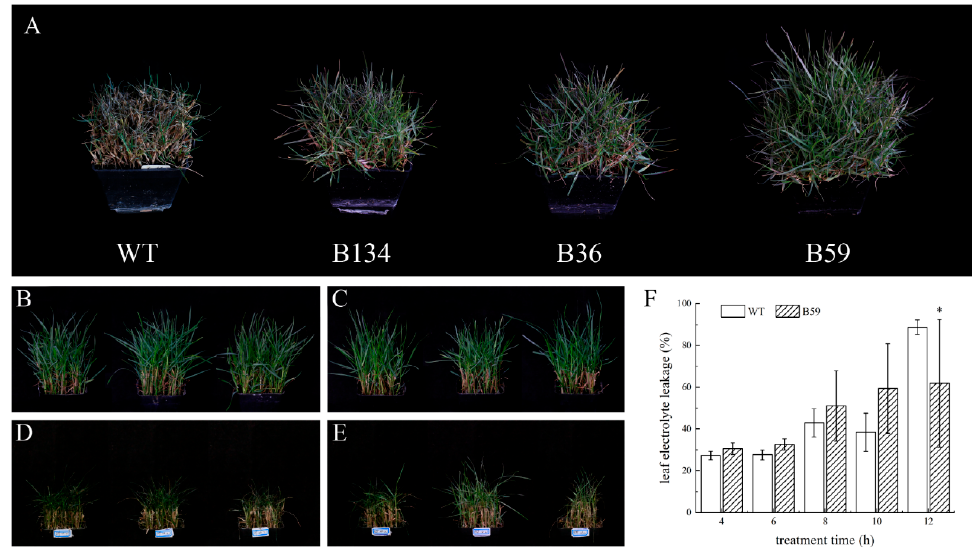
Figure 7. The performance of WT and B59 after freezing treatment. ( A ) Materials that perform well after the cold wave; ( B ) WT at 28 °C before freezing treatment; (C) B59 at 28 °C before freezing treatment; ( D ) WT thawed at 4 °C for 24 h after freezing treatment; ( E ) B59 thawed at 4 °C for 24 h after freezing treatment; ( F ) Changes of electrolyte leakage in leaves after treatment at − 7 °C for different time; * indicates significant differences ( p < 0.05).